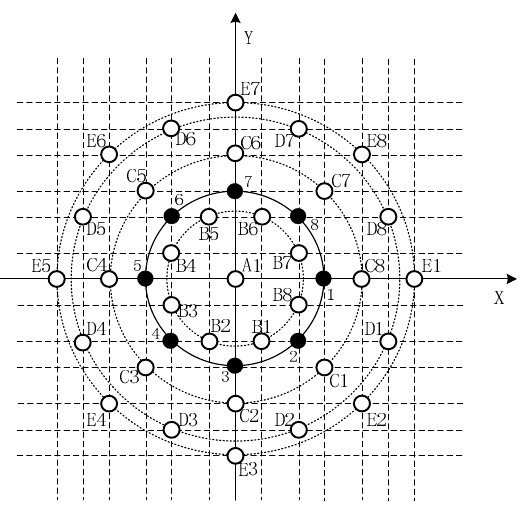
Figure 4. The corresponding virtual extension array of the uniform circular EVSA with eight elements.